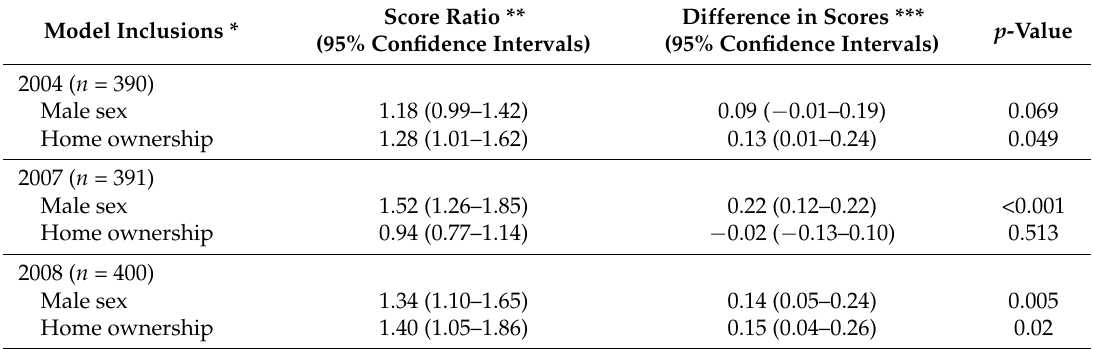
Table 3. Independent predictors of median and above breeding site scores—2004, 2007, and 2008. Model Inclusions